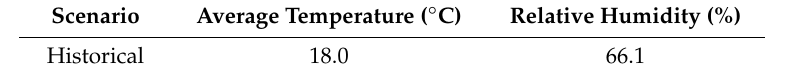
Table 1. Summary of average temperature and relative humidity in the historical scenario (1961–1990).